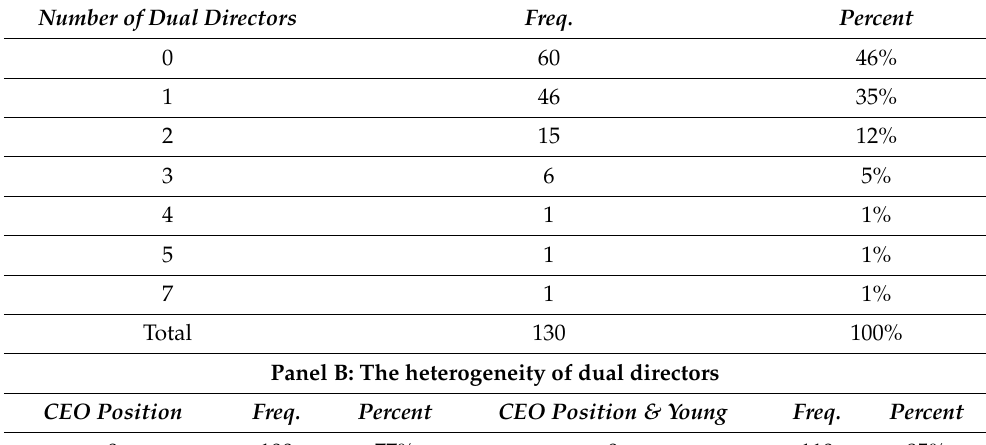
Table 2. Descriptive statistics for dual directors. Panel A reports the frequency of dual directors on both parent and subsidiary boards. Panel B reports the distribution of different types of dual directors based on whether they hold the CEO position in the subsidiary firm and whether they are younger than 60 years old. CEO position (non-CEO position ) are subsidiary firms with dual directors who hold the CEO (non-CEO ) position in the subsidiary firms. 3 CEO position & Young (Non-CEO position & Young ) are subsidiary firms with dual directors who hold the CEO (non-CEO) position in the subsidiary firms and are younger than 60 years old. Panel A: Distribution of dual